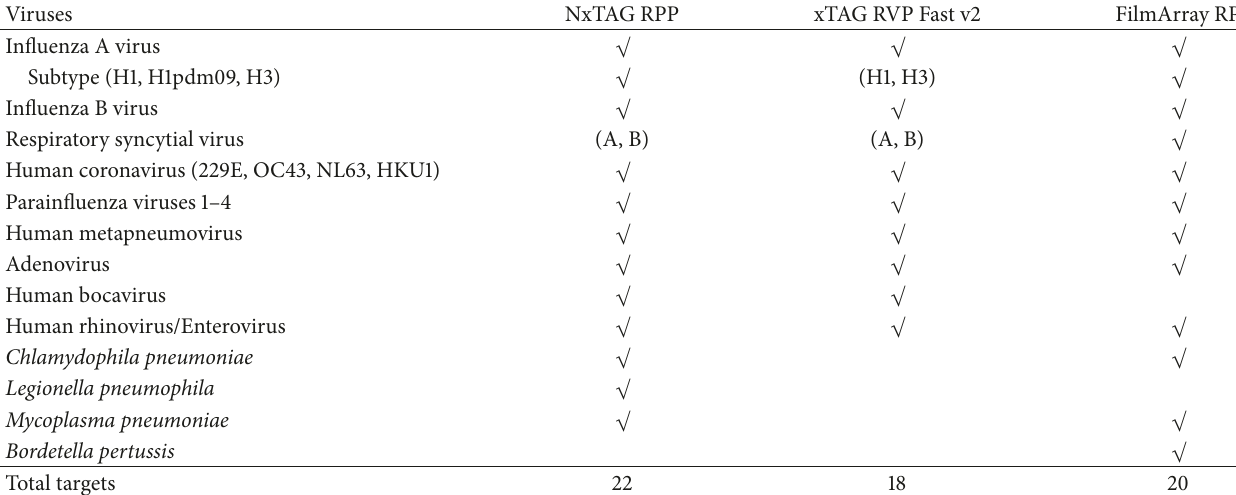
Table 1: Detectable pathogens and